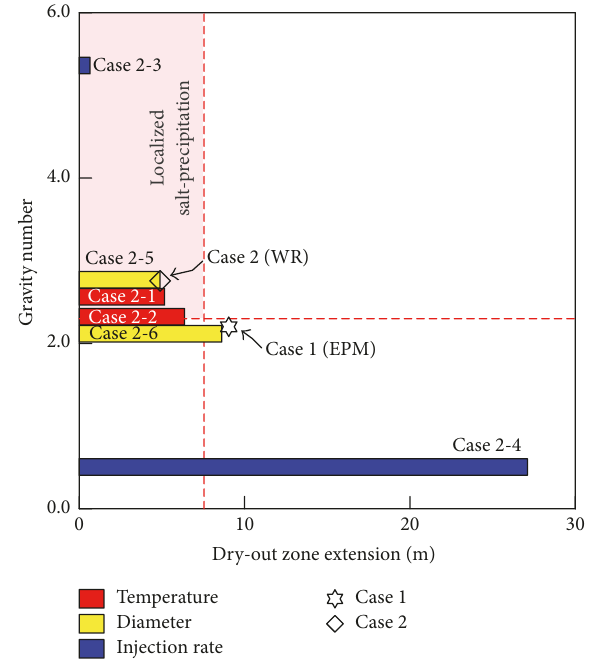
Figure10:Relationshipdelineatingbetweengravitynumberandthe location of dry-out front after 1,095 days. The red box indicates the area developing the localized